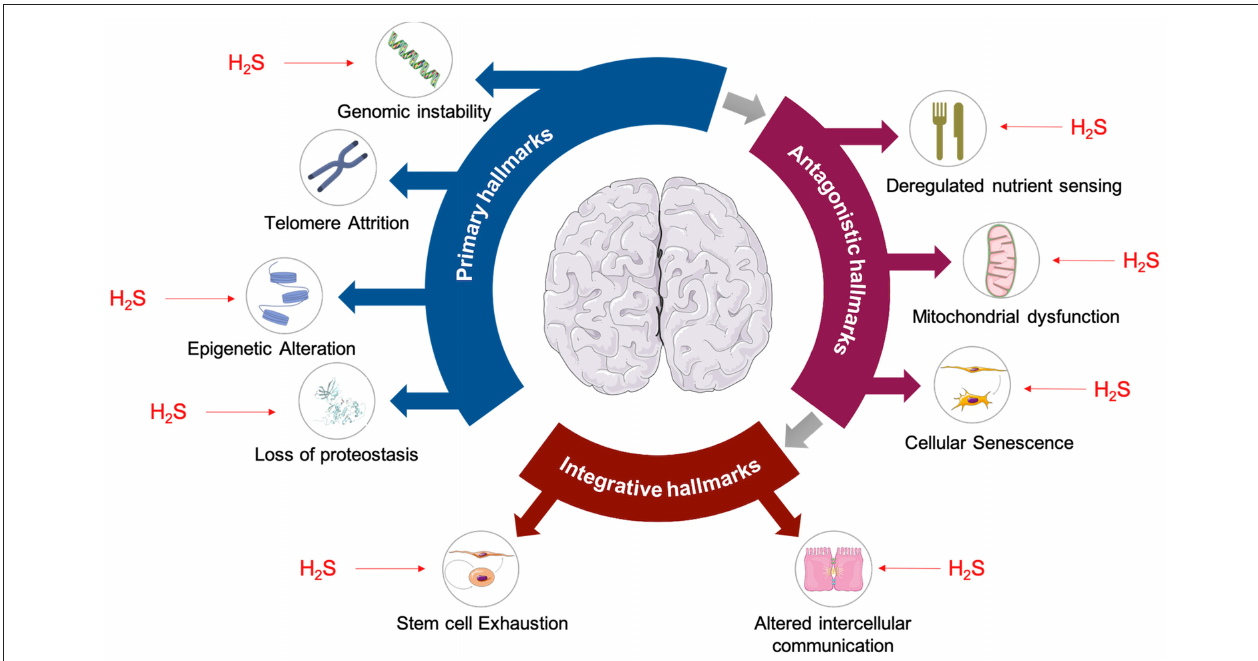
FIGURE 3 | Hallmarks of aging are affected by H 2 S. Primary hallmarks of aging shown to be affected by H 2 S are: genomic instability (Szczesny et al., 2014; Zhao et al., 2014 ), epigenetic alterations (Suo et al., 2013; Rios et al., 2015), and loss of proteostasis (Liu et al., 2013; Fawcett et al., 2015). Antagonistic hallmarks of aging such as deregulated nutrient sensing ( Xue et al., 2013; Ohno et al., 2015), mitochondrial dysfunction (Elrod et al., 2007; Sun et al., 2012), and cellular senescence ( Yang et al., 2013; Zheng et al., 2014) are also affected by H 2 S. Finally, H 2 S is also known to have effects on stem cell exhaustion (Liu et al., 2014a,b) and intracellular communication (Munaron et al., 2013), which are considered to be integrative hallmarks of